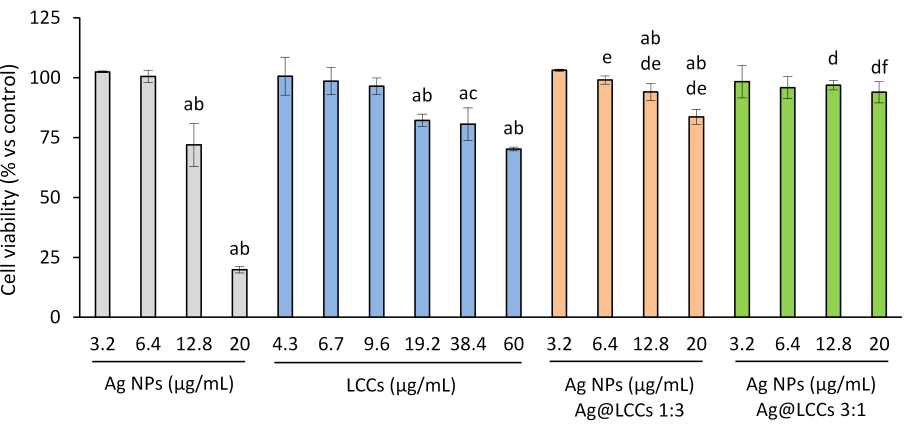
Figure 11. NIH/3T3 cell viability. NIH/3T3 fibroblasts were treated with Ag NPs (range: 3.2–20 µg/mL), LCCs (range: 4.3–60.0 µg/mL), or Ag@LCCs dispersions (range: 3.2–20